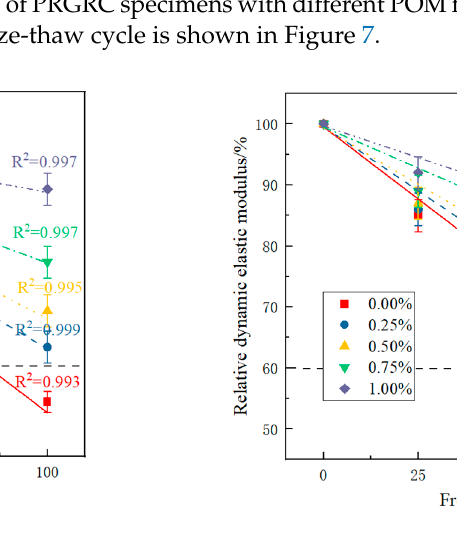
Figure 7. Fitting curve of relative dynamic elastic modulus of PRGRC with the number of freeze-thaw cycles: ( a ) 6 mm POM fiber; ( b ) 12 mm POM fiber.